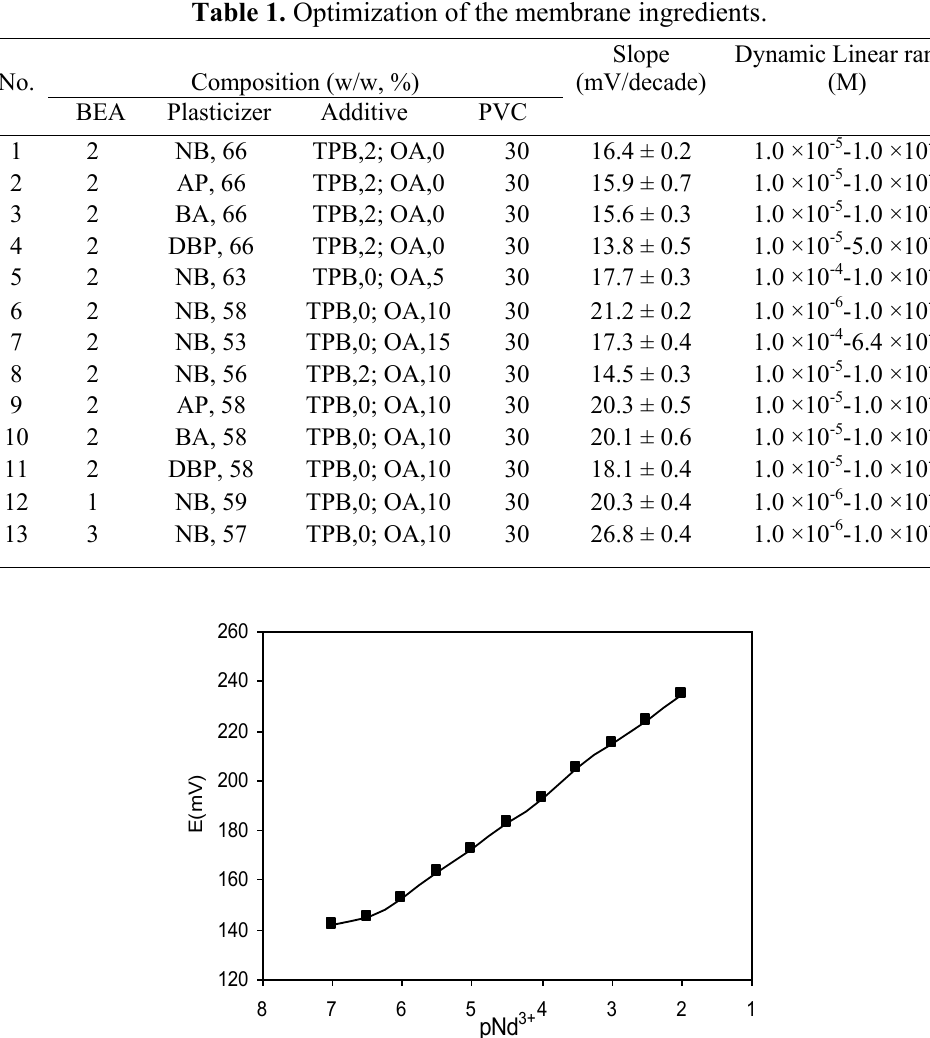
Figure 2. Calibration curve of the BEA based neodymium